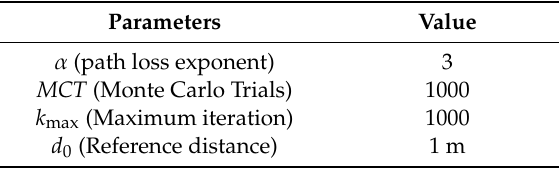
Table 2. Some fixed parameters in